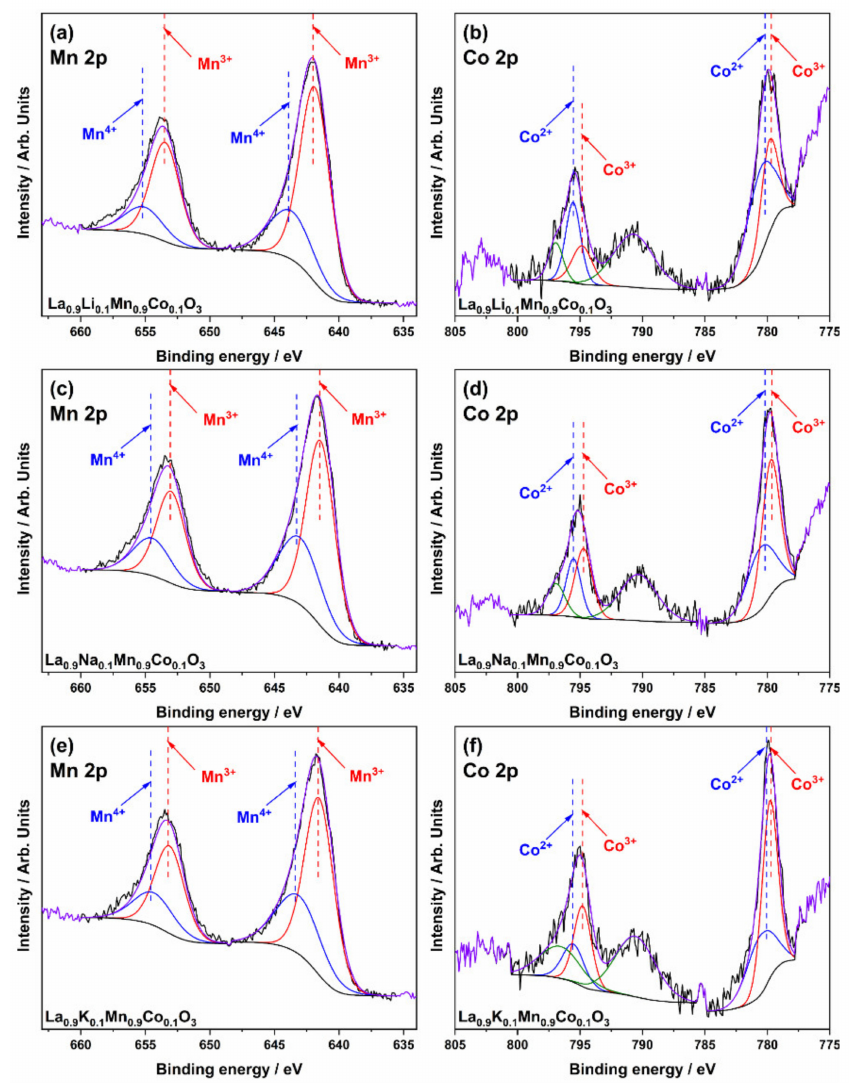
Figure 4. Mn 2p and Co 2p XPS spectra of La 0.9 Li 0.1 Mn 0.9 Co 0.1 O 3 ( a , b ), La 0.9 Na 0.1 Mn 0.9 Co 0.1 O 3 ( c , d ) La 0.9 K 0.1 Mn 0.9 Co 0.1 O 3 ( e , f )